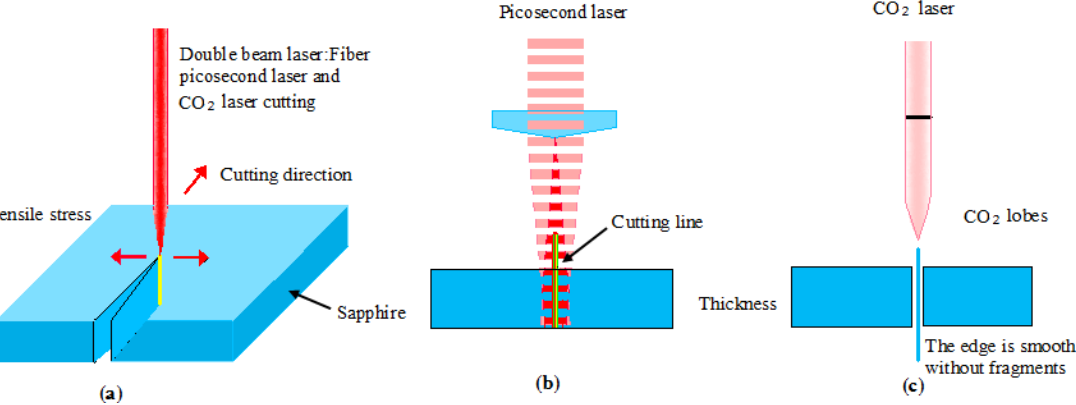
Figure 3. Schematic diagram of ultrafast double-laser-beam cutting. ( a ) Double-laser-beam cutting method; ( b ) Picosecond laser cutting; ( c ) CO 2 laser cutting.